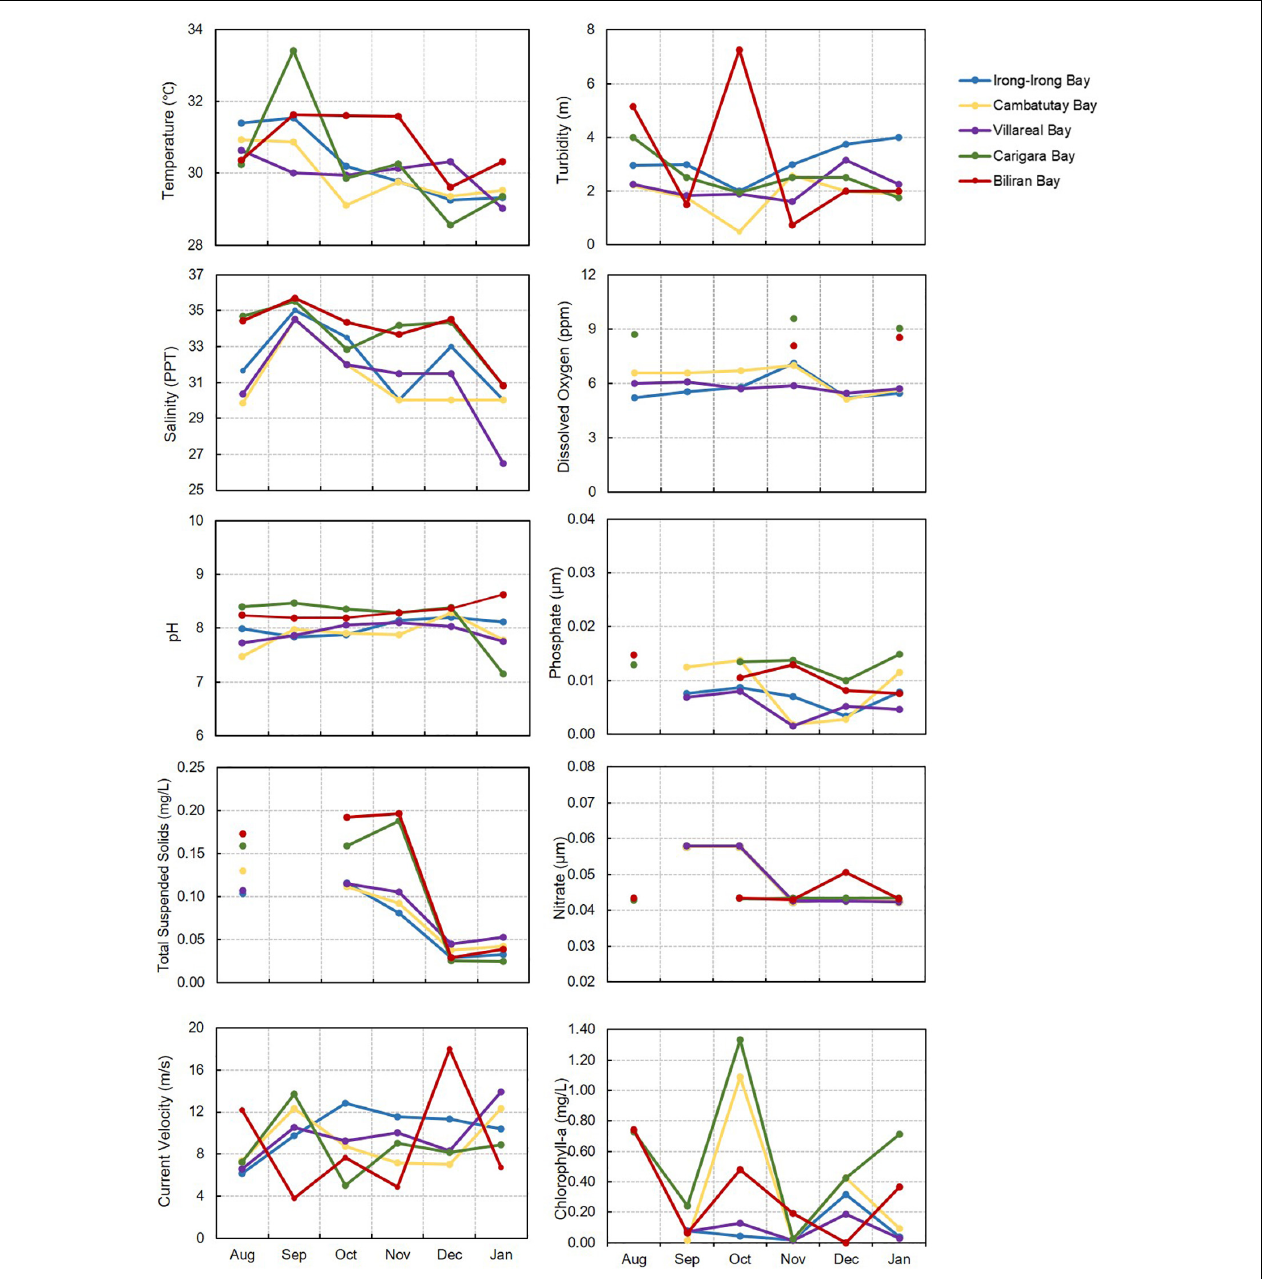
FIGURE 2 | Average measurement of physico-chemical parameters in the five HAB-affected bays in Eastern Visayas from August 2020-January 2021, including the inorganic nutrients (nitrates and phosphates). The number of parameters measured varied depending on the availability of the equipment during sampling and weather or sea